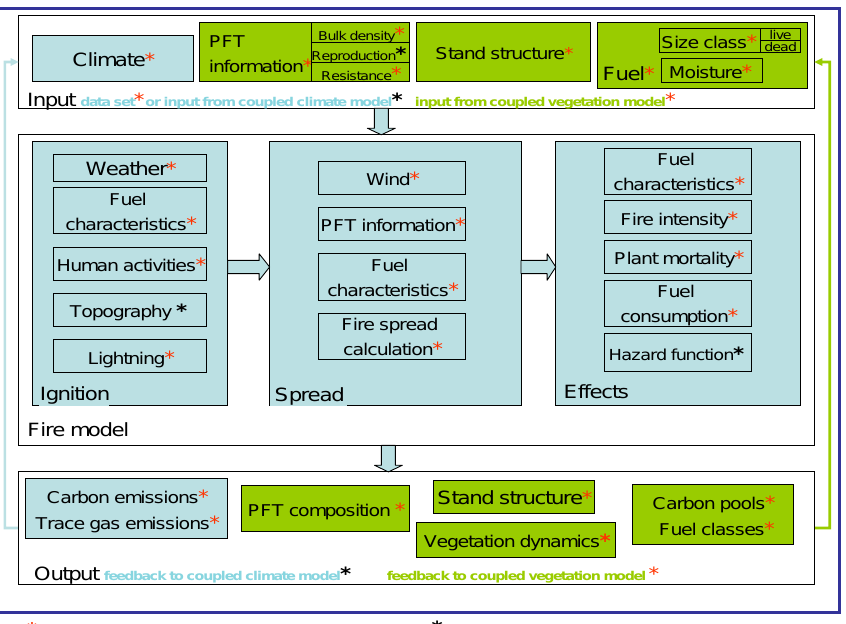
Fig. 1. Scheme describing model features a process-based fire model for dynamic vegetation models or climate-vegetation models should consider (following Fosberg et al., 1999; Keane et al., 2004; Pausas et al.,